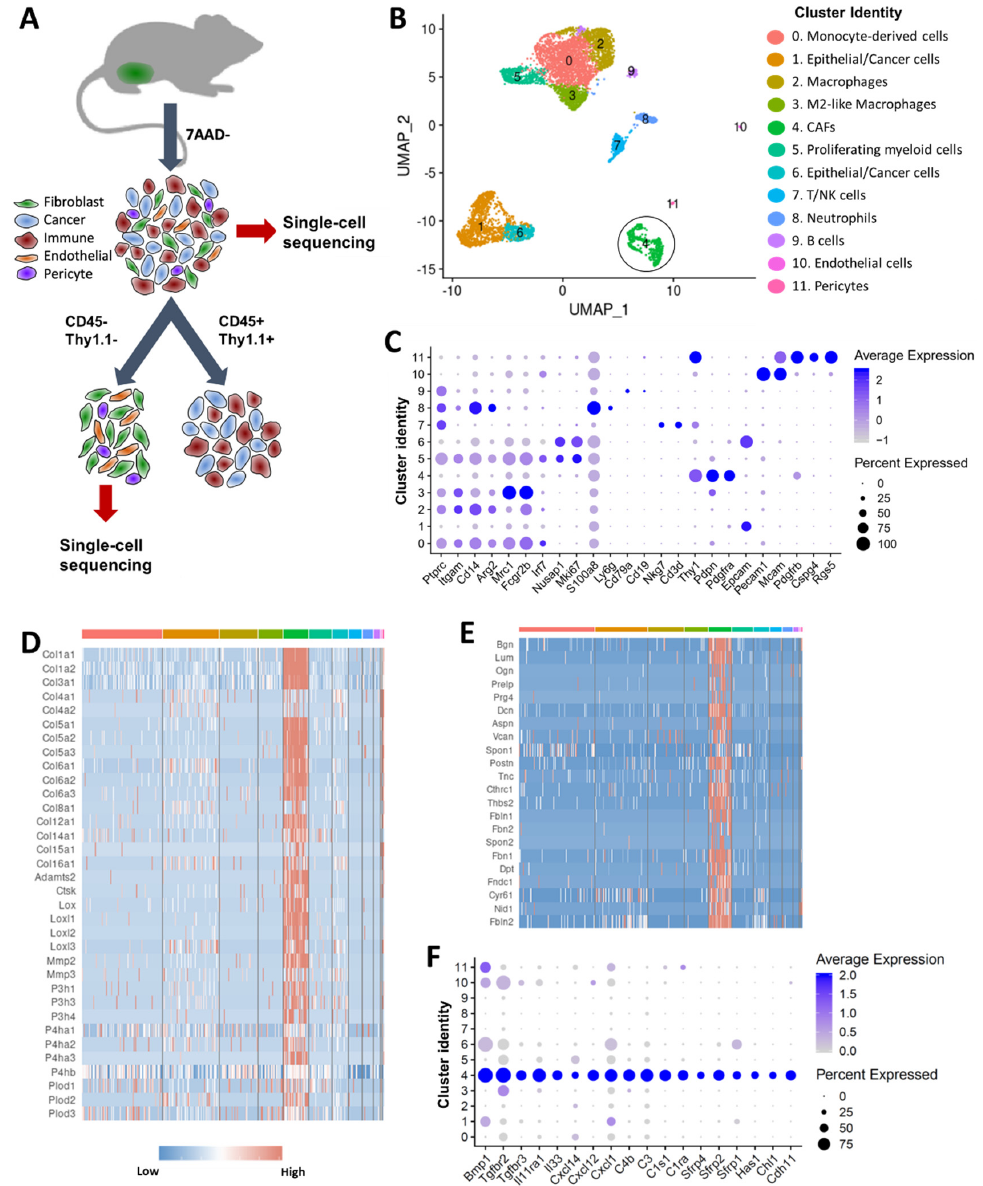
Figure 1. Single cell analysis of 4T1 mouse mammary tumors. ( A ) Graphical representation of the experimental workflow. 4T1 syngeneic tumors were dissociated into single cells, and two cell fractions were generated: (1) a viable cell fraction (7AAD − ) and (2) immune-depleted stromal cell fraction (obtained by depleting CD45+ immune cells and Thy1.1+ cancer cells). Cells from both fractions were subjected to single cell sequencing using the 10x Genomics Chromium platform. ( B ) Cell clusters from 10x Genomics scRNA-seq analysis visualized by Uniform Manifold Approximation and Projection (UMAP). Colors indicate clusters of various cell types (CAFs in black circle). ( C ) Dot plot showing the expression of selected markers of various cell types. Dot size represents the fraction of cells expressing a specific marker in a particular cluster and intensity of color indicates the average expression level in that cluster. ( D ) Heatmap showing high levels of collagens and collagen-processing enzymes in CAFs. ( E ) Heatmap showing high levels of key proteoglycans and glycoproteins in CAFs. ( F ) Dot plot showing the expression of a subset of genes enriched in CAFs. Dot size represents the fraction of cells expressing a specific marker in a particular cluster and intensity of color indicates the average expression in that cluster.